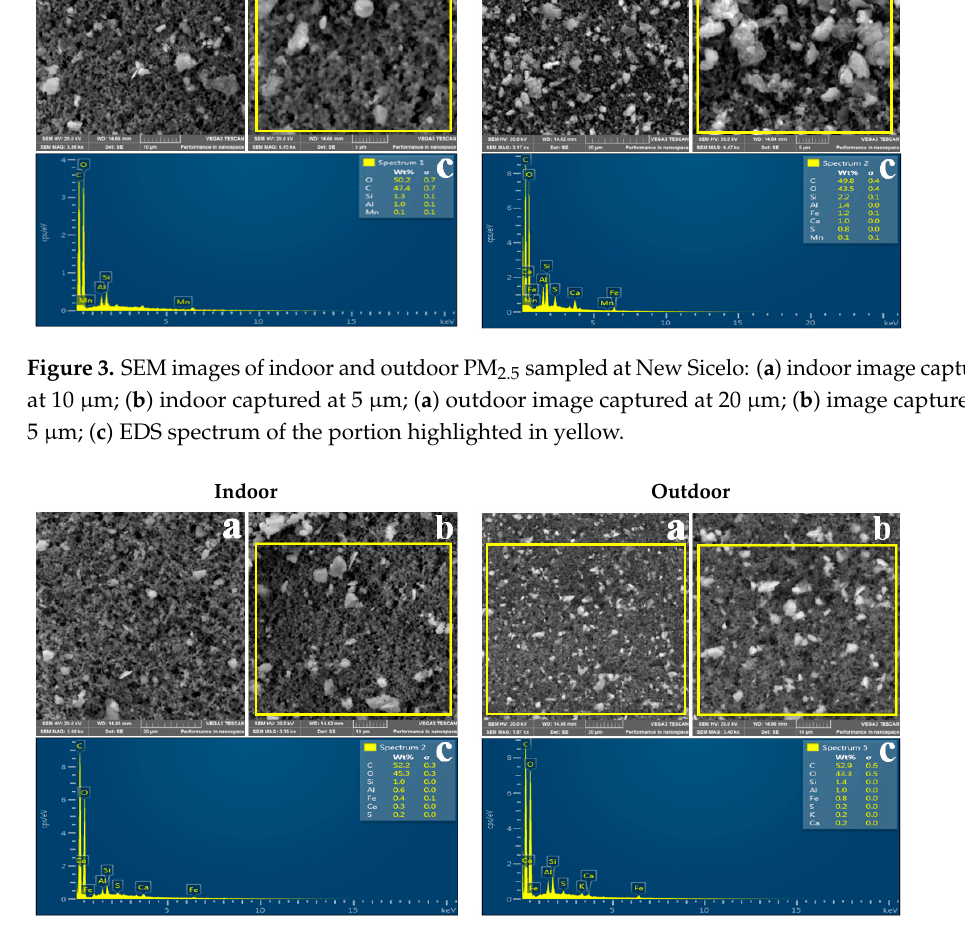
Figure 4. SEM images of indoor and outdoor PM 2.5 sampled at Noldick: ( a ) image captured at 20 µm; ( b ) image captured at 10 µm; ( c ) EDS spectrum of the portion highlighted in yellow. Table 3 shows particle diameter results for the indoor and outdoor PM 2.5 sampled in the three residential areas. The mean size of the indoor particles ranged between 0.38 and 0.49 µm, whereas the mean size of outdoor particles ranged between 0.3 and 0.37 µm. It can be observed that both indoor and outdoor PM 2.5 in the three residential areas were in the accumulation mode (0.1–1 µm). Table 3. Indoor and outdoor particle diameter (µm) measurements in the three residential areas. Parameter